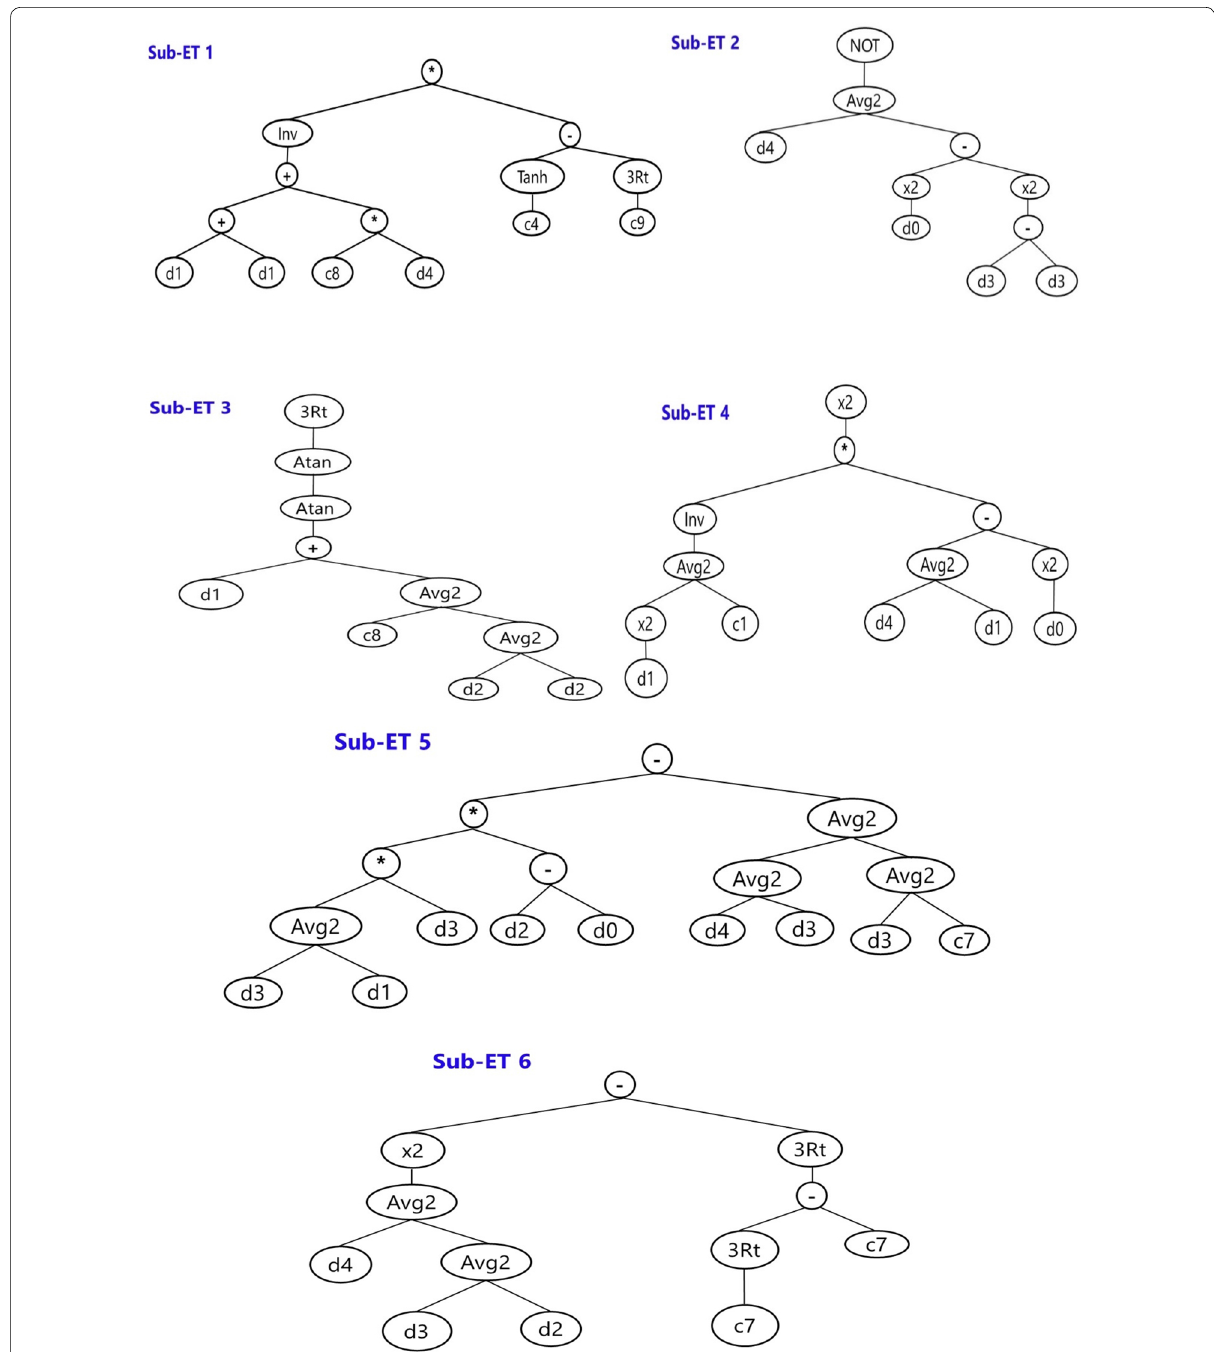
Fig. 4 Expression tree for the